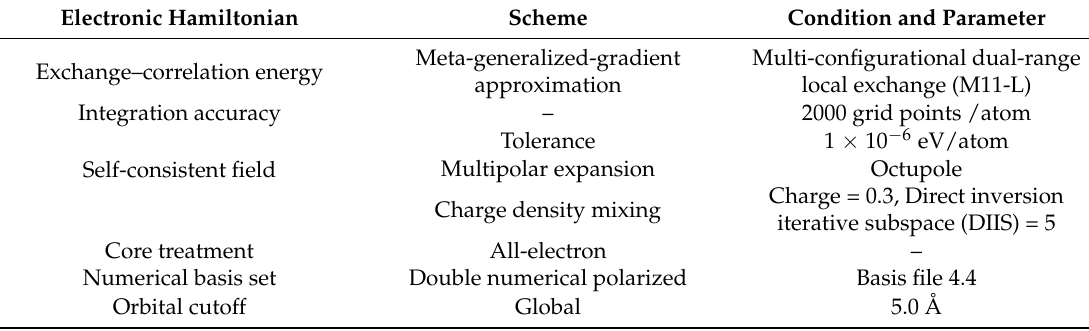
Table 2. Methodology and parameters adopted in first-principles